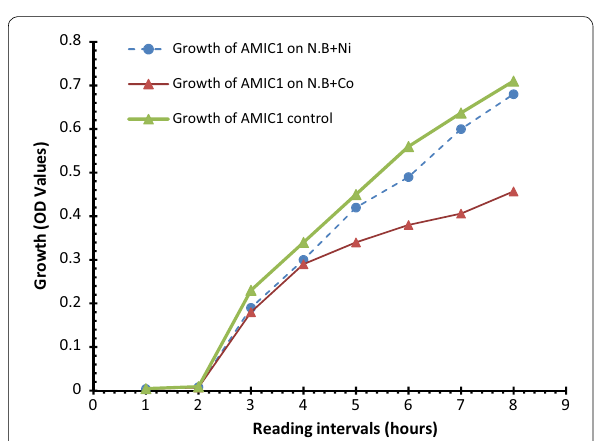
Fig. 2 Graph showing effect of Ni and Co vs. control on growth rate of Klebsiella variicola strain AMIC1